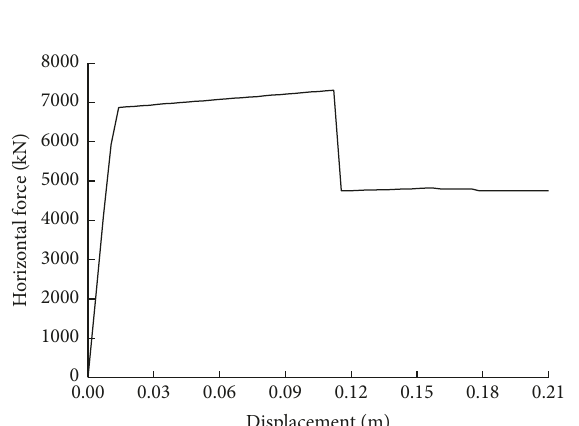
Figure 10: Horizontal force-deformation curve.